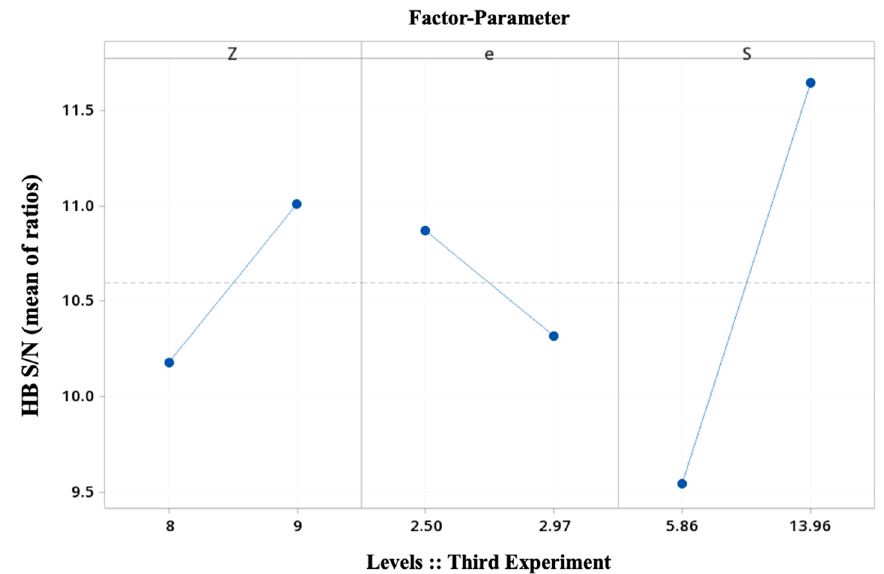
Figure 13. Main effects plot for the third Taguchi experiment (see Table 6).